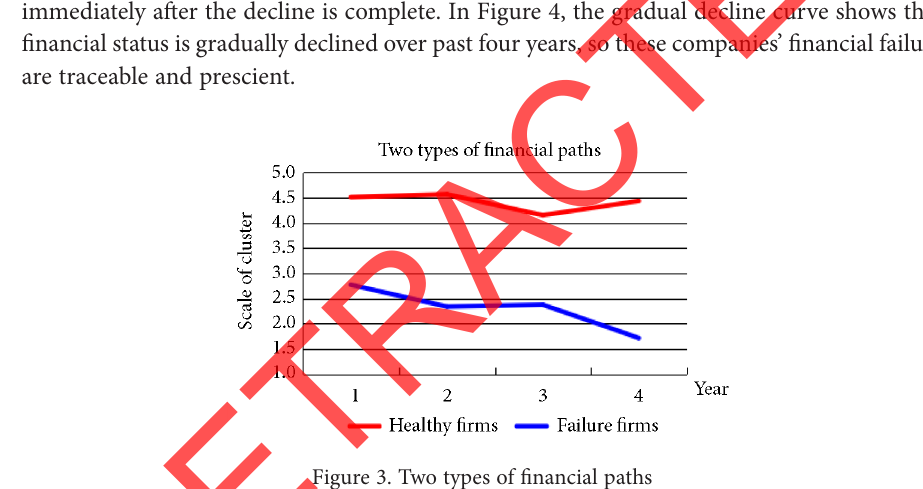
Figure 3. Two types of financial paths